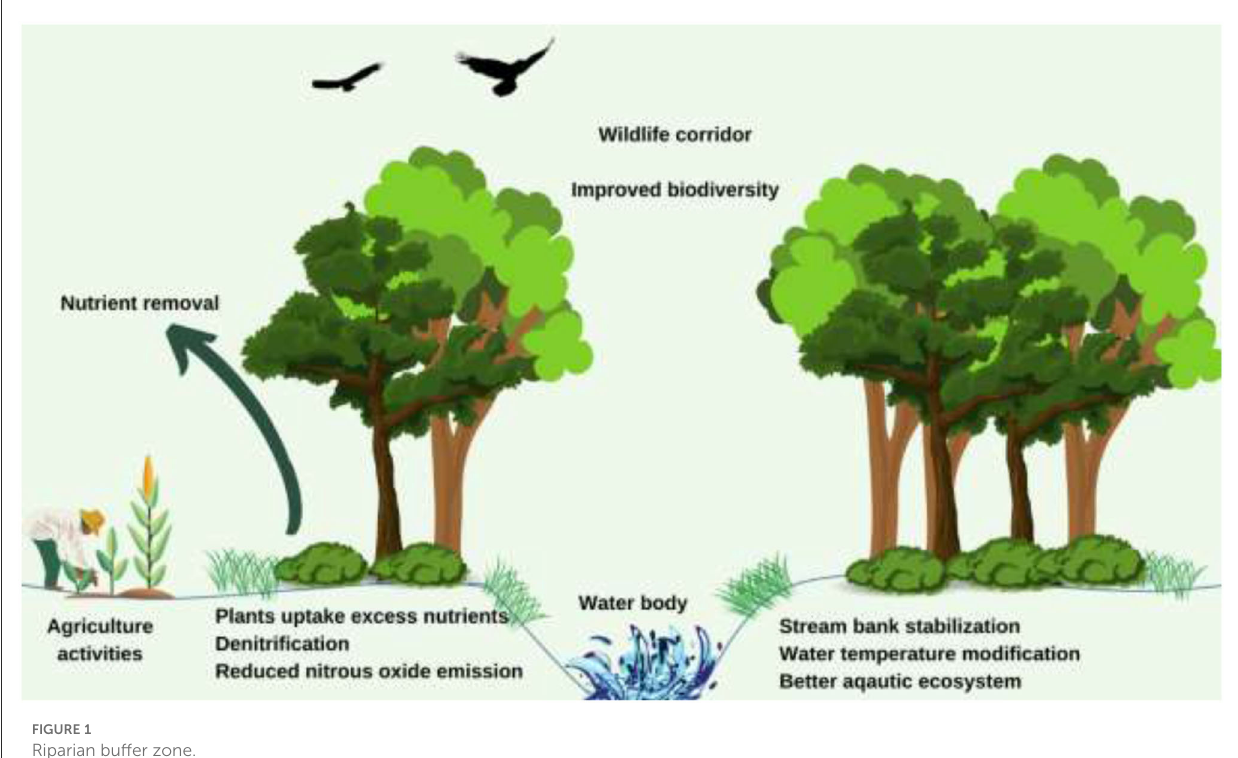
FIGURE1 Riparian buffer zone.